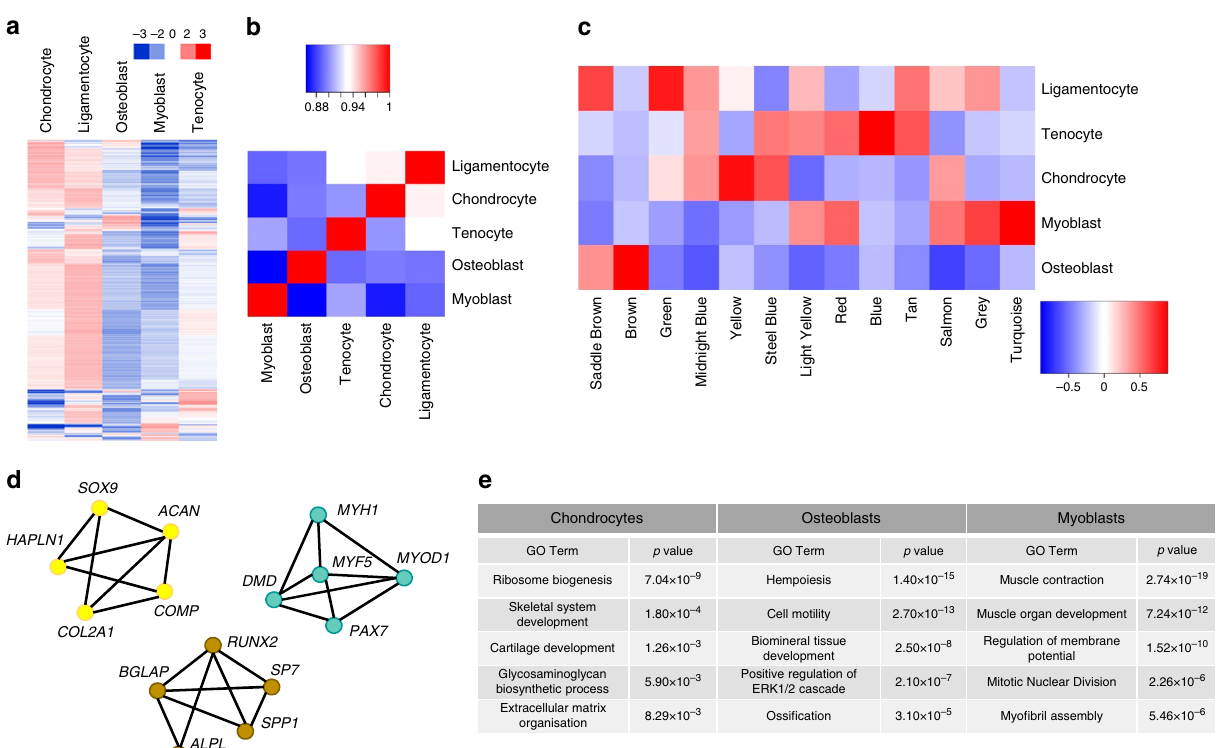
Fig. 2 Identi fi cation of tissue-speci fi c gene modules during human fetal musculoskeletogenesis. a Hierarchical clustering of the top 5000 expressed genes across all fi ve cell types. b Spearman correlation analysis of the total transcriptomes of the same fi ve tissues. c WGCNA delineated 13 modules based on patterns of gene co-expression in each tissue. Each column represents a unique gene module. Relative gene expression levels are indicated using the color scale. d String network demonstrating validity and connectivity of selected tissue-speci fi c genes from the chondrocyte (Yellow), osteoblast (Brown) and myoblast (Turquoise) gene modules. e Selected Gene Ontology terms enriched in the chondrocyte, osteoblast and myoblast modules. N = 3 –